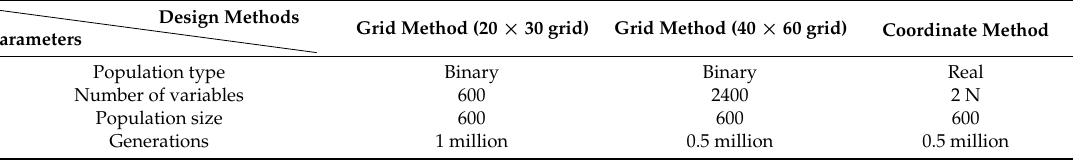
Table 3. Setting of genetic algorithm (GA) parameters of the wind farm layout optimization using different design